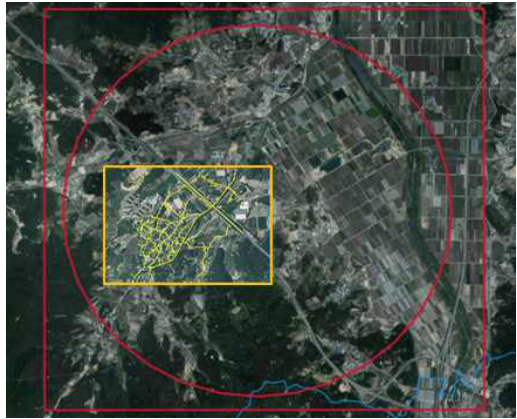
Figure 2. Target area for DSM and OM